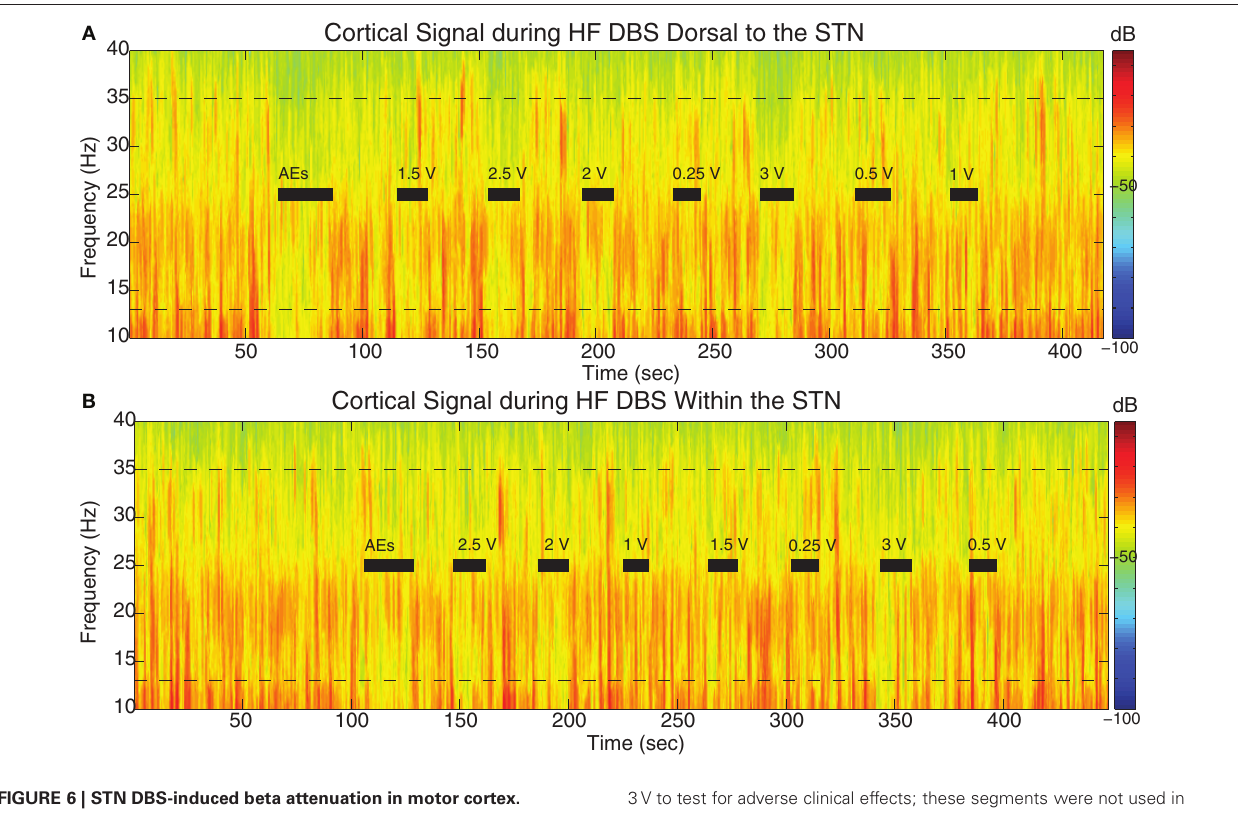
FIGURE 6 | STN DBS-induced beta attenuation in motor cortex. Spectrogram of single cortical ECoG channel during STN DBS (A) 1.5mM dorsal to the dorsal border of the STN and (B) within the STN (2.6mM below dorsal border) from a representative patient (case 6). Black bars indicate the full time period that HF DBS was on. The bars marked “AEs” demark the period of time when HF DBS was increased from 0 to